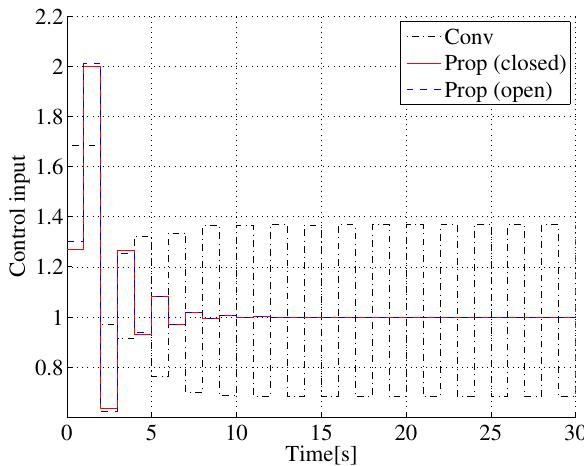
Figure 7. Input trajectories for stable